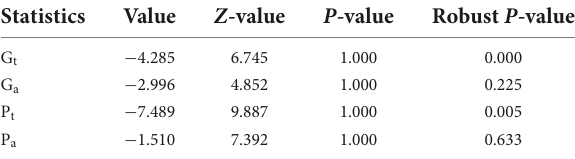
TABLE 5 Westerlund co-integration test.